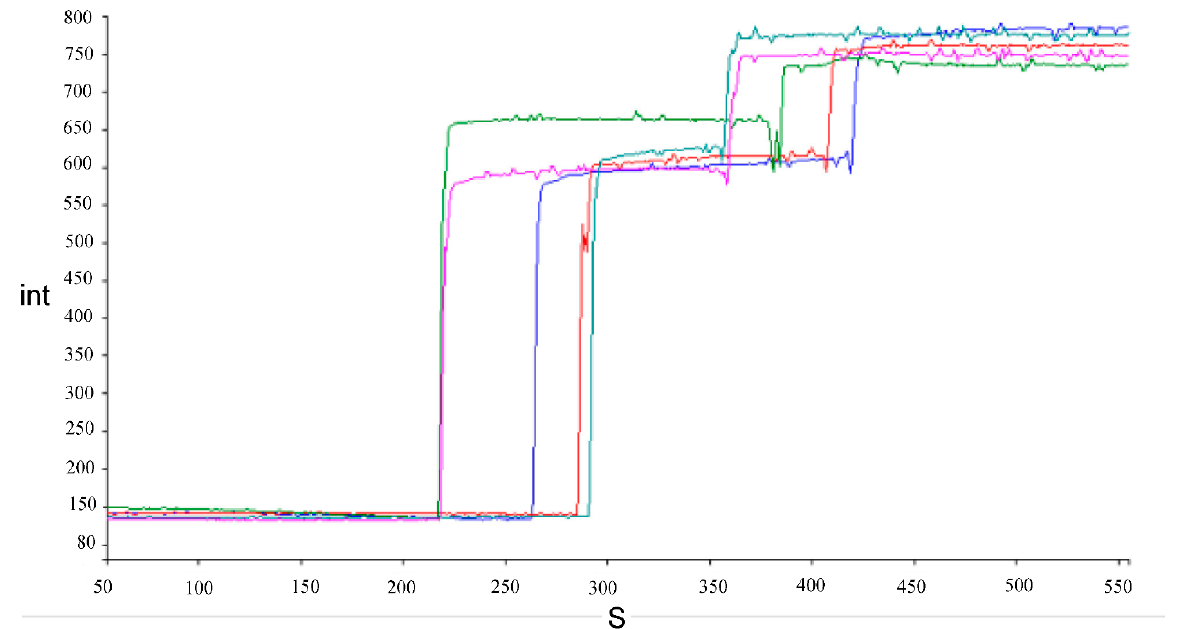
Figure 3. Examples of traces of fluorescence intensity (int) increase during time in seconds (S) for energized Lacticaseibacillus cells after addition of 1.5% ( w / v ) bile salts and FCCP in succession. Each color represents a different strain, namely, L. paracasei AN-15-3 (blue), J-7-1 (olive green) and J-15-4 (sea green), L. rhamnosus AN-21-2 (purple), and G-7-14 (red).